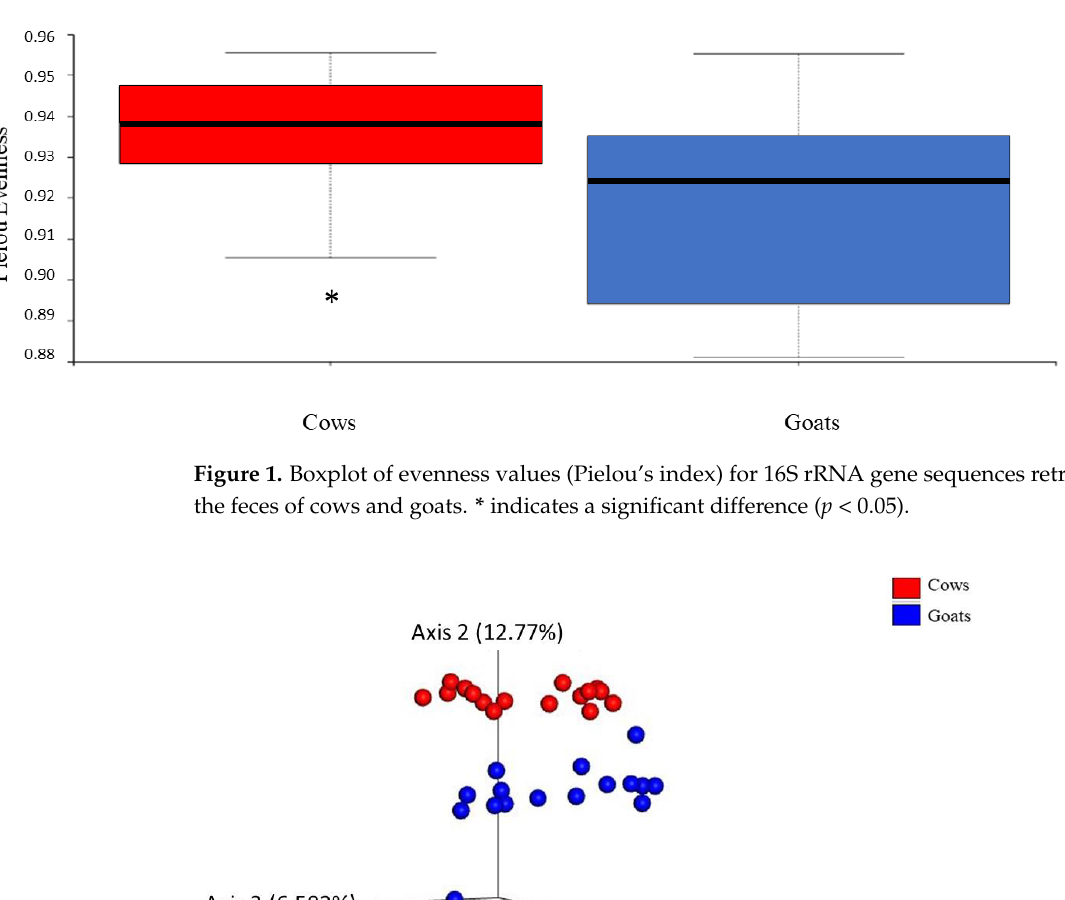
Figure 1. Boxplot of evenness values (Pielou's index) for 16S rRNA gene sequences retrieved from the feces of cows and goats. * indicates a significant difference ( p < 0.05).